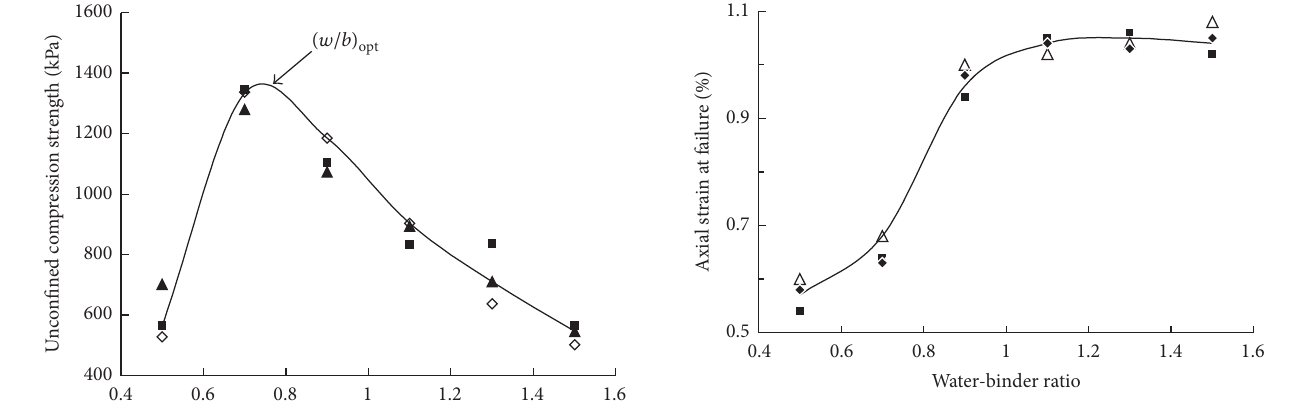
Figure 11: Variation of failure strain for different water-binder ratio.